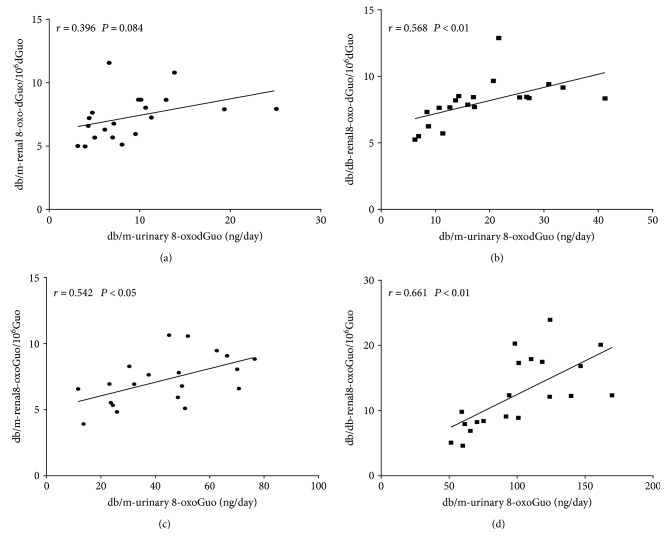
Correlations between urinary 8-oxodGuo/8-oxoGuo and renal 8-oxodGuo/8-oxoGuo. (a) Correlation between urinary 8-oxodGuo/day and renal 8-oxodGuo/106dGuo in db/m mice (r = 0.396, P = 0.084). (b) Correlation between urinary 8-oxodGuo/day and renal 8-oxodGuo/106dGuo in db/db mice (r = 0.568, P < 0.01). (c) Correlation between urinary 8-oxoGuo/day and renal 8-oxoGuo/106Guo in db/m mice (r = 0.542, P < 0.05). (d) Correlation between urinary 8-oxoGuo/day and renal 8-oxoGuo/106Guo in db/db mice (r = 0.661, P < 0.01).